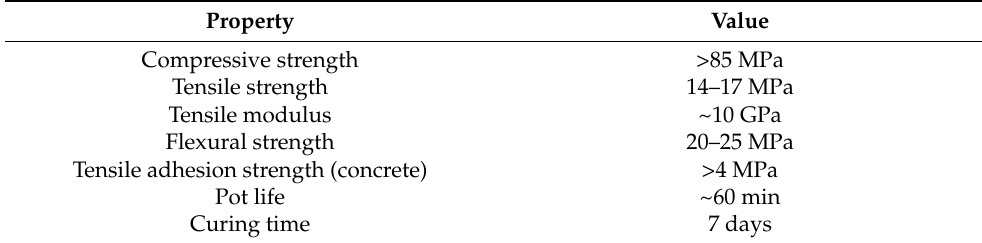
Table 1. Mechanical properties of Sikadur 30 LP cured at 25 ◦ C. Property Value Compressive strength >85 MPa Tensile strength 14–17 MPa Tensile modulus ~10 GPa Flexural strength 20–25 MPa Tensile adhesion strength (concrete) >4 MPa Pot life ~60 min Curing time 7